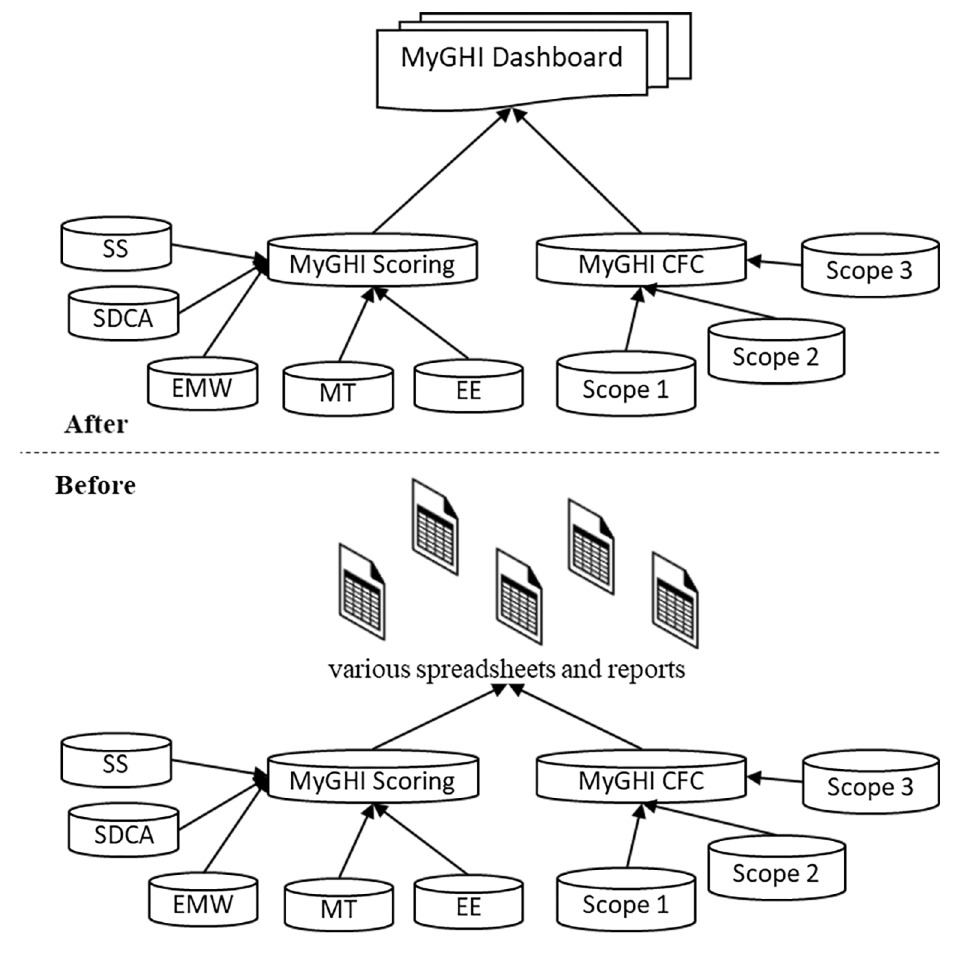
Figure 7. MyGHI performance measures data system